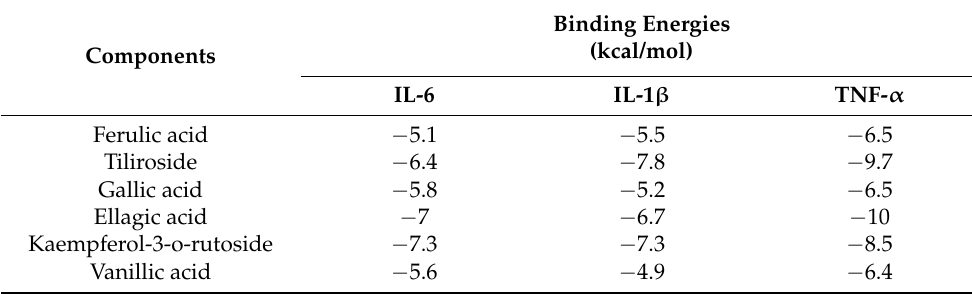
Table 2. The binding energy of six phenolic components to target